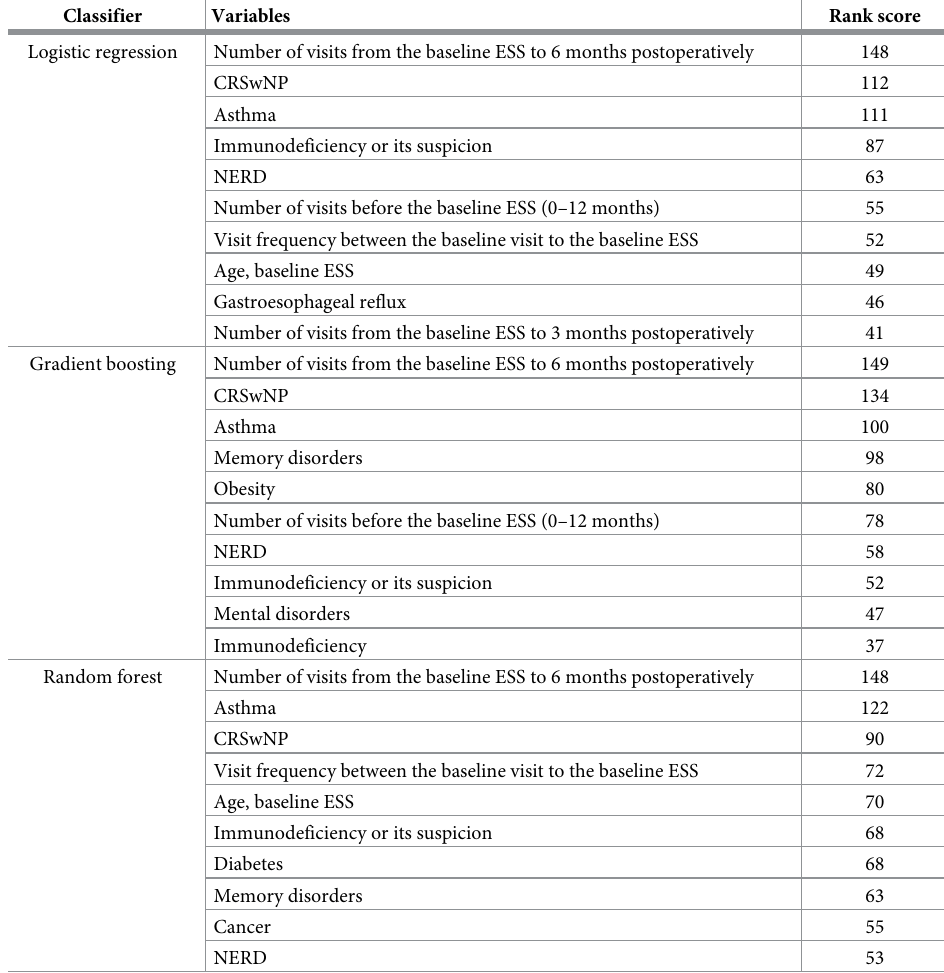
Table 6. The top ten variables in prediction capacity of revision ESS. Three models were used and the classifiers of the three models were the logistic regression, gradient boosting and random forest for predicting revision ESS. We used the sequential forward selection (SFS) method to select the top performing variables. In each SFS run, the best var- iable was awarded 15 points, the next best variable 14 points and so on. Ten runs were performed using each of the three classifiers. The rank score represents the sum of points (range, 0–150 points).